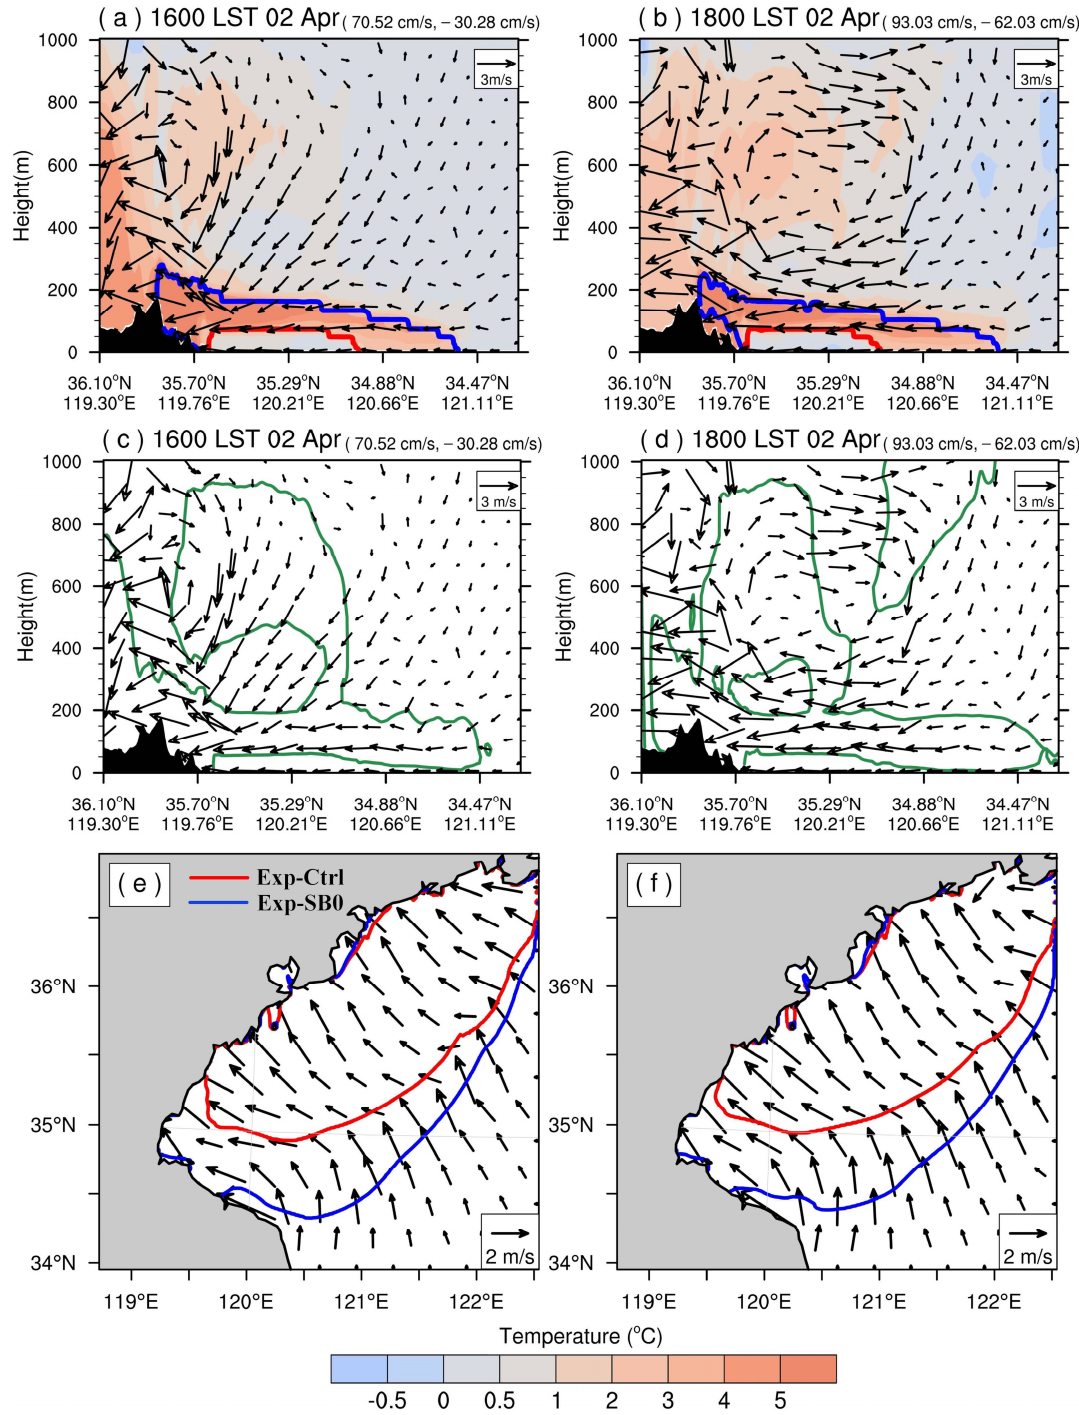
Figure 10. Panels ( a – d ) show the vertical cross-section along the line A-B marked in Figure 1 for the sea breeze circulation (vectors), the differences of Exp-Ctrl minus Exp-SB0 for temperature (shades in ( a , b )) and RH (contours in ( c , d ); only those lines with the values of − 5% are shown for clarity). Panels ( e , f ) present the horizontal display for sea fog area with the differences of 10-m wind of Exp-Ctrl minus Exp-SB0. The sea fog vertical extents of Exp-Ctrl and Exp-SB0 ( a , b ) are outlined by the coarse lines in blue and red colors, respectively. The maximal vertical velocities are shown at the upper right corner of the panels ( a – d ) and the horizontal velocities in the lower right of the panels ( e , f ).